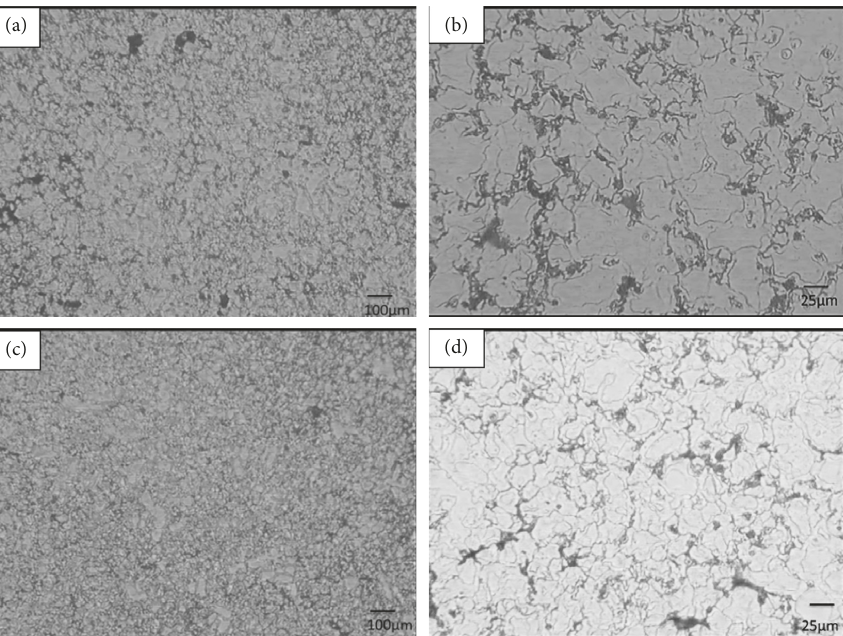
Figure 5: Optical microstructures for the CED by AZ91D+0.1wt.% Ce + 0.1wt.% Li alloy (a, b). Power coated on AZ91D+0.1wt.% Ce+0.1wt.% Li alloy (c, d).